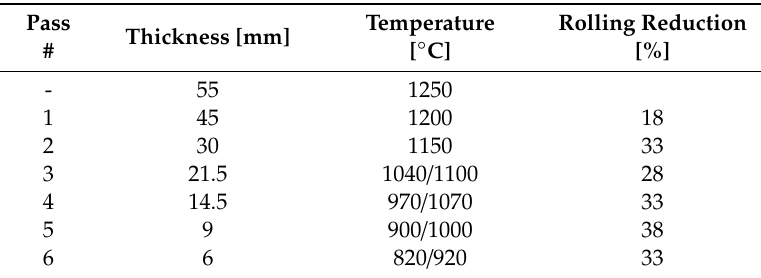
Figure 1b. These two sets of experiments were meant to simulate quenching after hot rolling without and with controlled rolling finishing at low temperatures. Table 2. Hot rolling pass schedules.